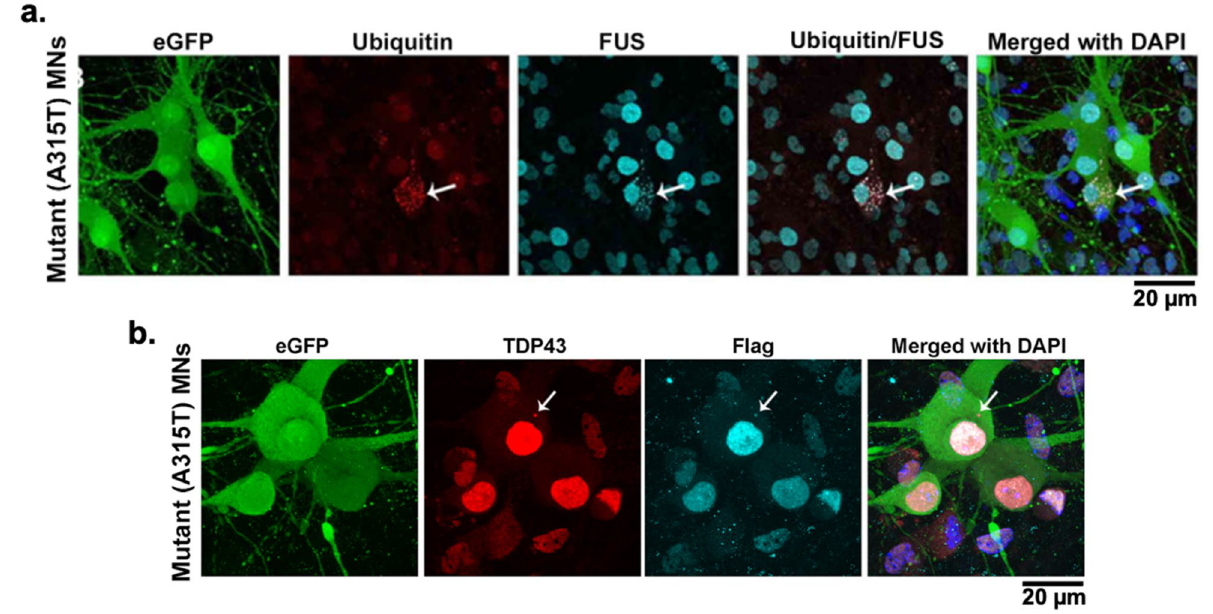
Figure 4. Validation of mutant TDP-43-A315T transgene as the source of cytosolic TDP-43 aggregates. ( a ) Immunocytochemical staining of mutant MNs. 32.2 ± 34.8% (n ≥ 5) of Mutant (A315T) cell-derived motor neurons also expressed FUS and co-localized with cytosolic ubiquitinated aggregates (indicated with arrows). ( b ) Immunocytochemical staining showing the cytosolic co-localized FLAG peptide with that of the TDP-43 (indicated with arrows), validating the generation and presence of TDP-43 in the mutant cells is due to the mutant gene.